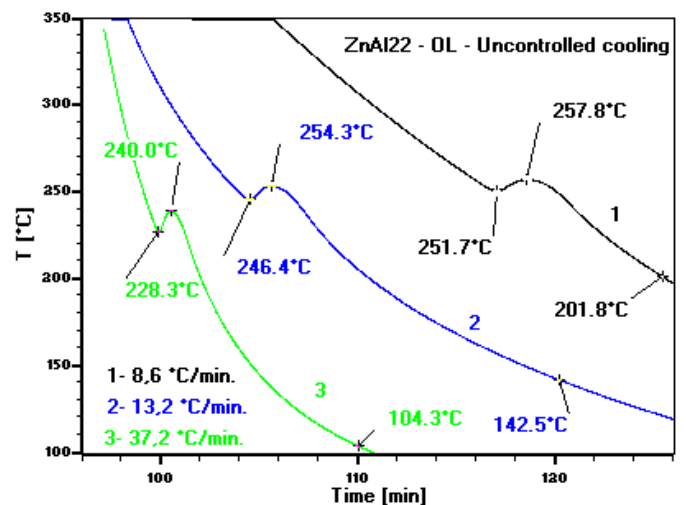
Figure 11. Cooling curves registered during DIL analysis, when the cooling was un-controlled for the gravity casted alloy and using steel die.